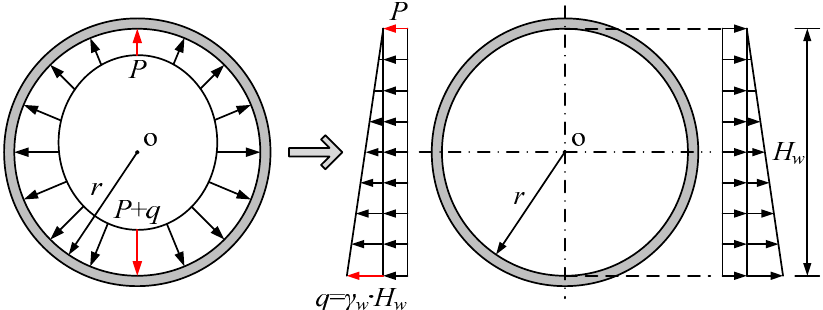
Figure 1. Diagram of internal load in the section of pressurized water conveyance tunnel.